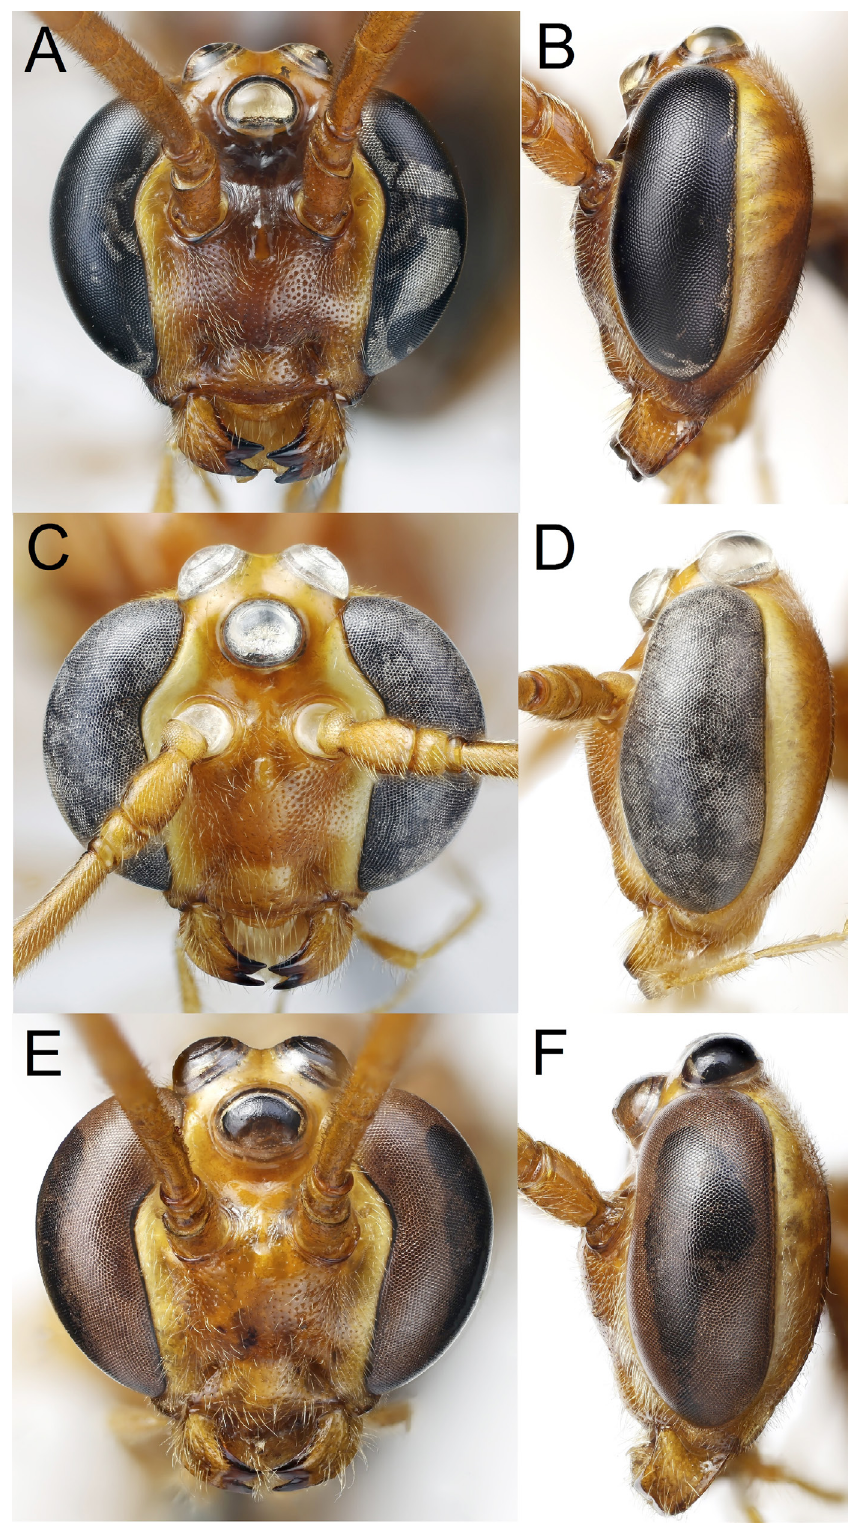
Fig. 19. head in anterior and lateral view of female. A‒B . Ophion vardali Johansson sp. nov., paratype, ♀ (NHRS-HEVA000008748). C‒D . O. inclinans Johansson sp. nov., holotype, ♀ (NHRS- hEVA000008667). E‒F . O. pteridis Kriechbaumer,